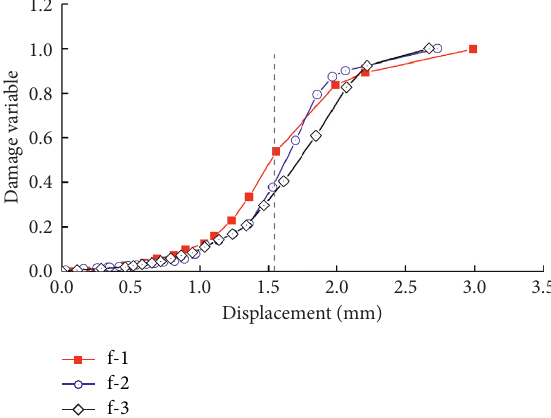
Figure 8: The damage variable-displacement curves of salt rock